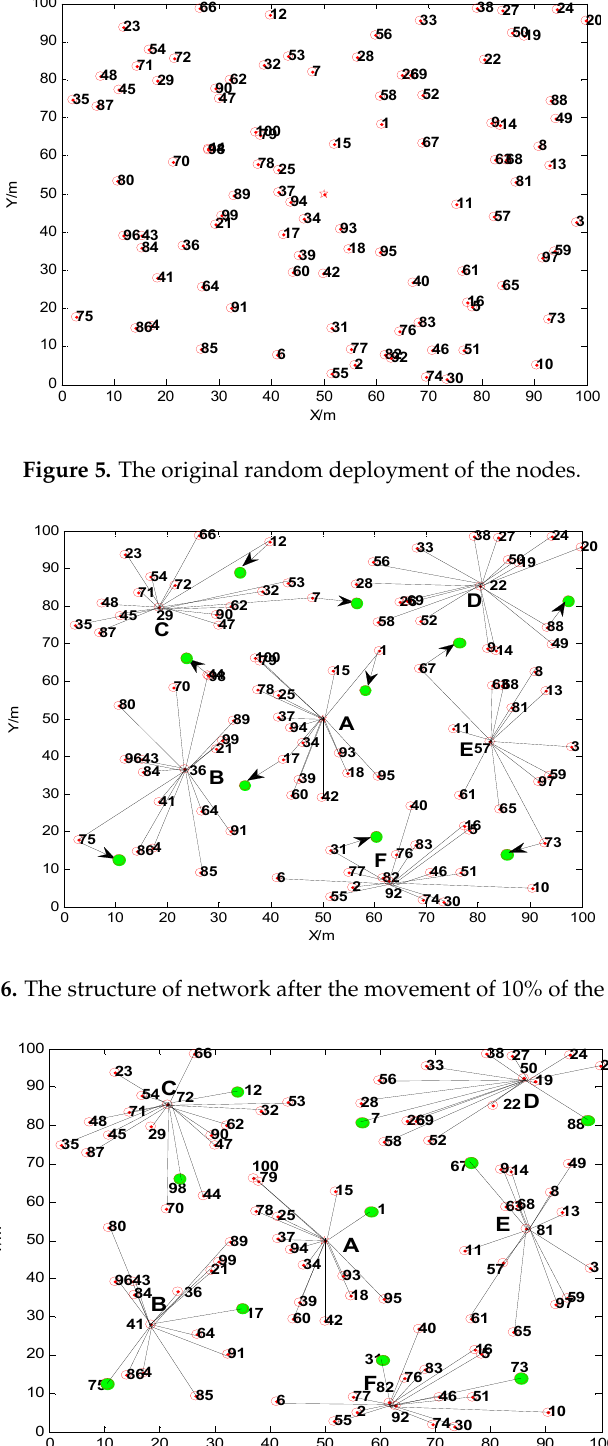
Figure 7. The clustering topology of network for a new round after nodes’ movement.